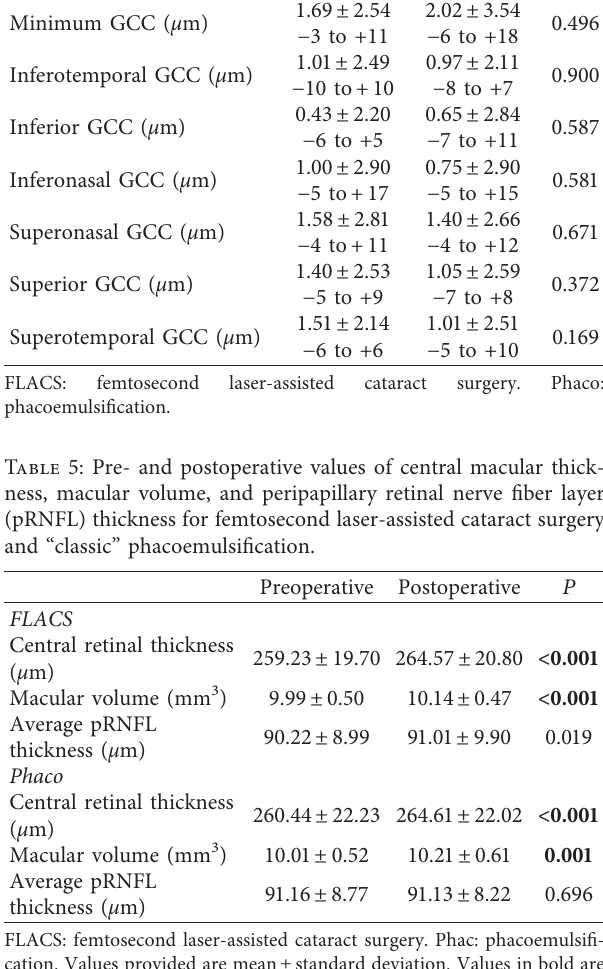
FLACS: femtosecond laser-assisted cataract surgery. Phac: phacoemulsifi- cation. Values provided are mean ± standard deviation. Values in bold are those considered statistically significant taking into account the Bonferroni correction. Table 6: Differences in pre- and postoperative values of central macular thickness, macular volume, and peripapillary retinal nerve